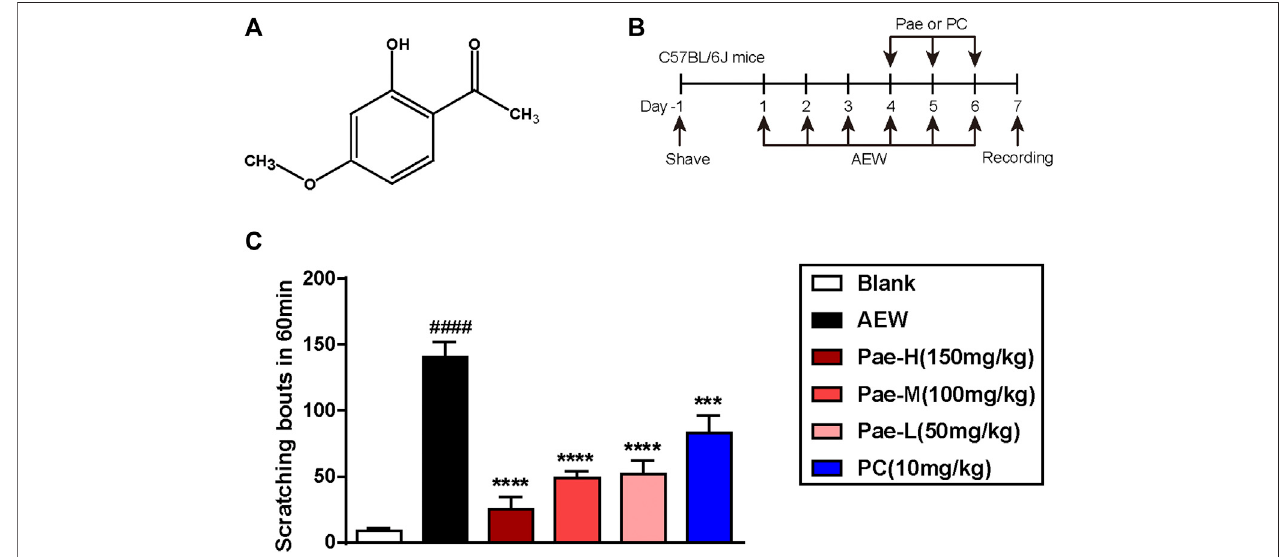
FIGURE 1 | Paeonol alleviated AEW-induced scratching behavior of dry skin mice. (A) The chemical structure of paeonol. (B) Schematic diagram of the animal experimental protocol. Spontaneous scratching of mice was videotaped and analysed. (C) The behavior results of different groups on day 7. Data were expressed as mean ± SEM. ### p < 0.001, compared with the blank group. ** p < 0.01, *** p < 0.001, compared with the AEW model ( n (cid:1) 6 – 7 each group). Pae-H, paeonol-high dose; Pae-M, paeonol-middle dose; Pae-L, paeonol-low dose; PC, positive control drug, HC-030031. The relevant labels in the following fi gures are the same unless otherwise